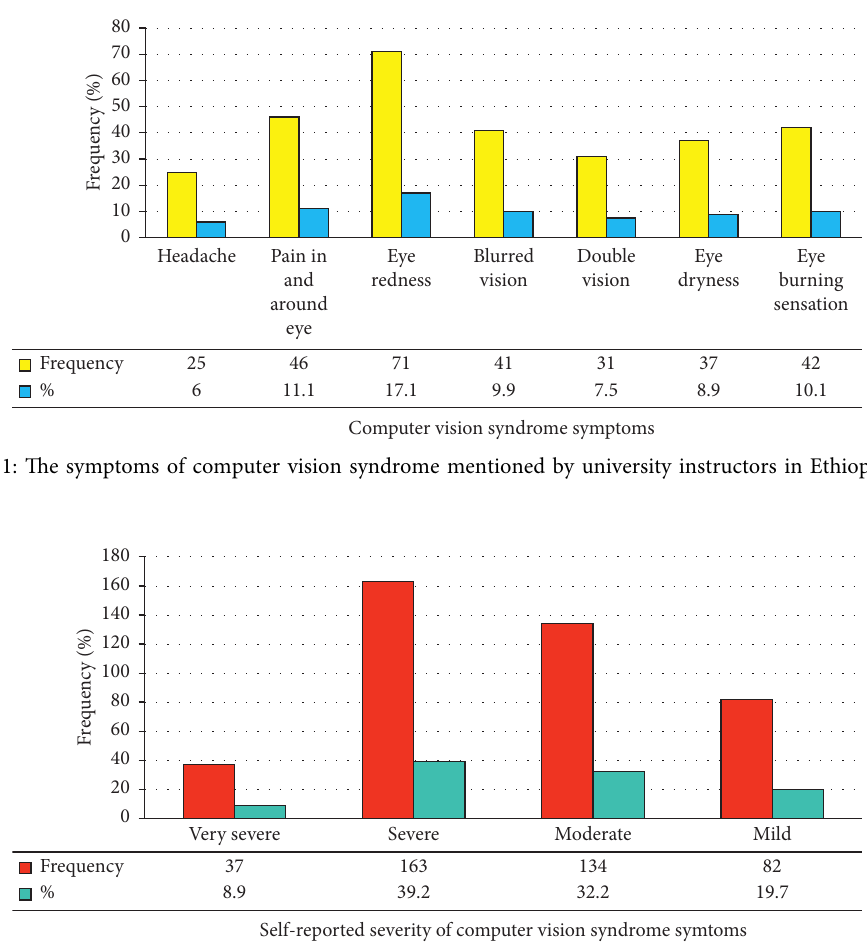
Figure 2: Self-reported severity of computer vision syndrome symptoms among instructors working in Ethiopia universities, 2021. Table 3: Bivariable and multivariable logistic regression analysis for computer vision syndrome among instructors in Ethiopian universities, 2021 ( n �